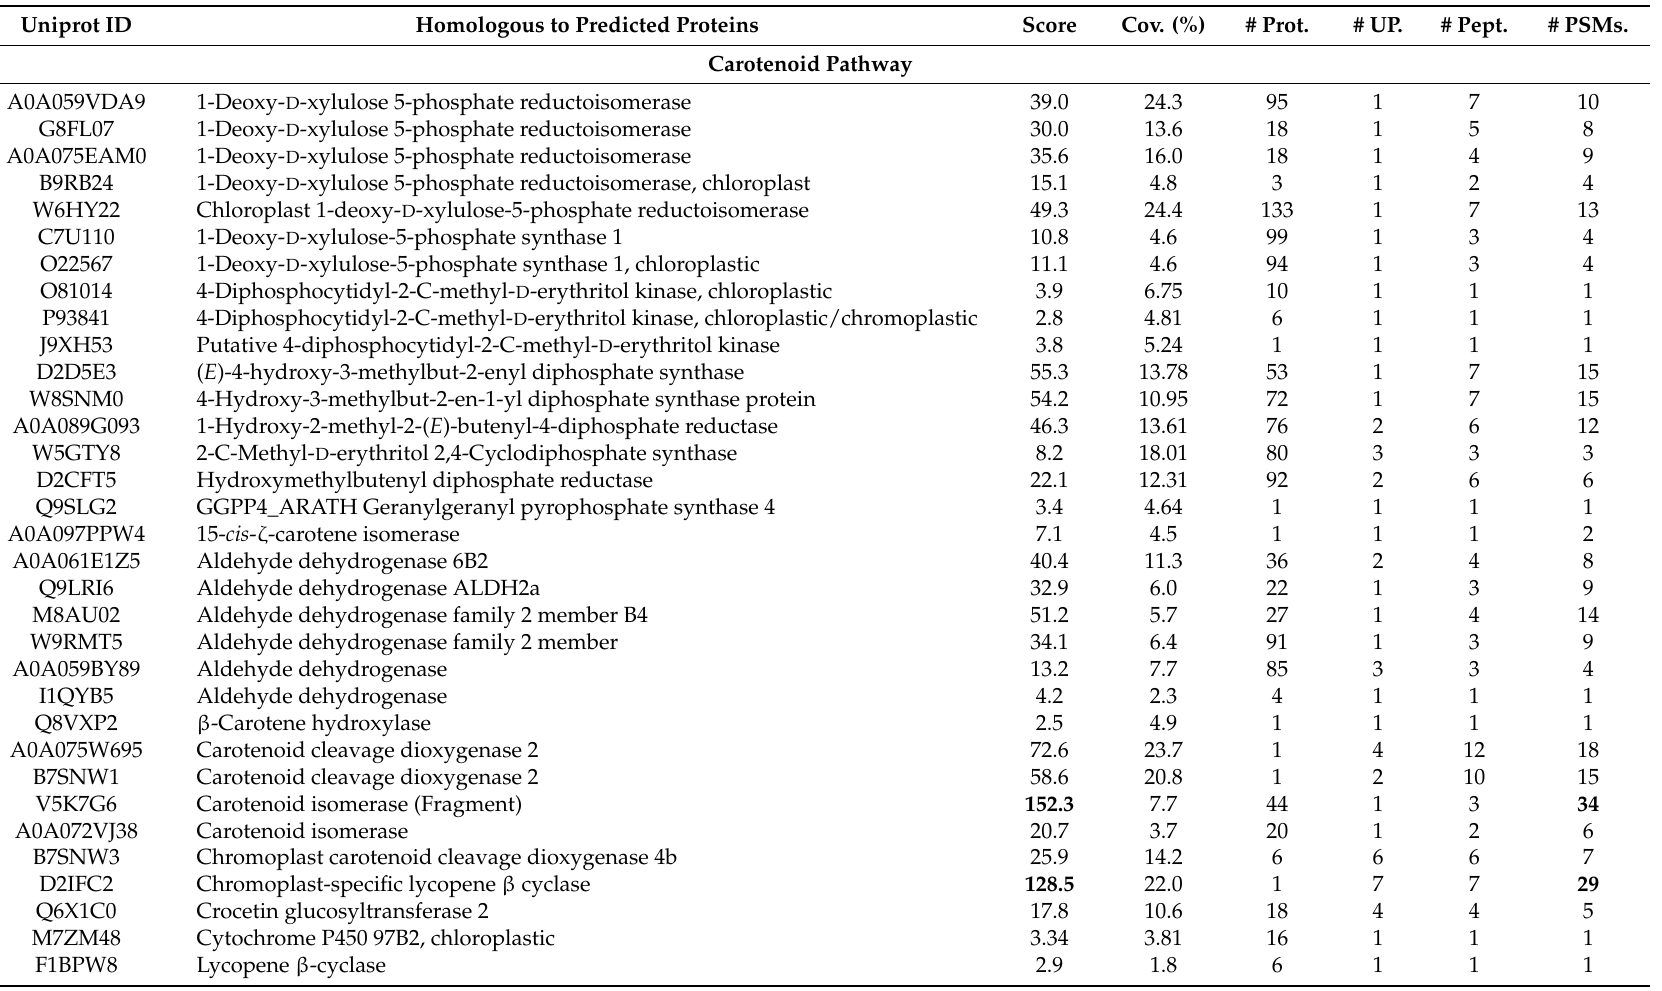
Table 2. Identification of proteins involved in carotenoid pathway and plastid-lipid-associated proteins, deduced from LC-MS/MS data of fraction F2 from saffron